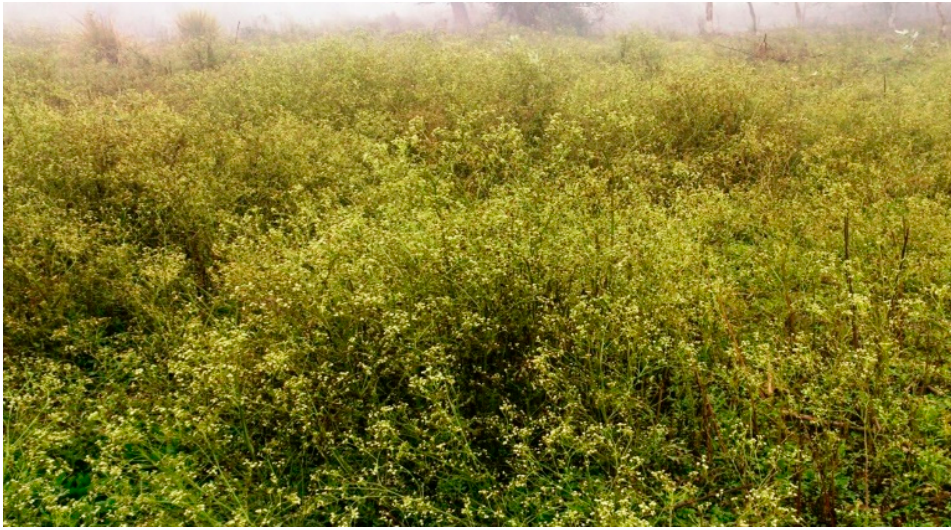
Figure 1. Parthenium weed invasion in Jhok reserve forest, Punjab, Pakistan.